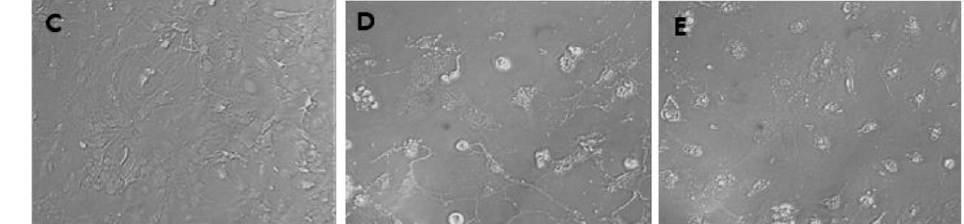
Figure 2. Dose-toxicity of ZnO NPs in primary cultured astrocyte cells. Cell viability was assessed using lactate dehydrogenase (LDH) release ( A ) and 3-(4,5-dimethylthiazol-2-yl)-2,5-diphenyltetrazolium bromide (MTT) reduction ( B ) assays. Representative microscopic images of astrocytes using phase-contrast ( C – E ): ( C ) control; ( D ) 3 μ g/mL of ZnO NPs; ( E ) 10 μ g/mL of ZnO NPs. Data represents the mean ± SEM. * p < 0.05, ** p < 0.01 compared to control ( n = 4).